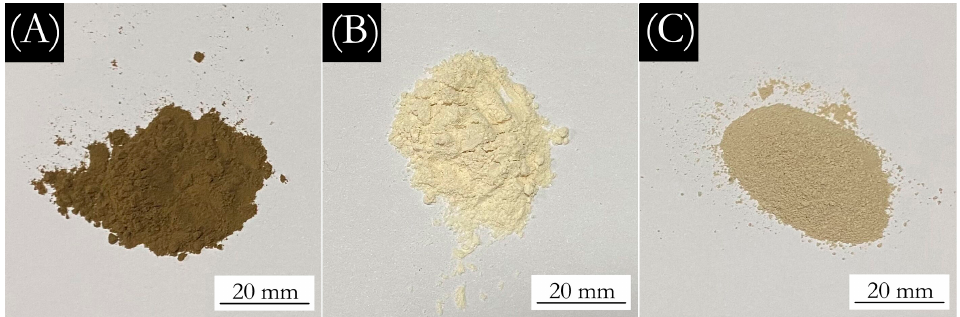
Figure 1. The macroscopic topography: ( A ) the aloin powder, ( B ) the aloin microcapsules prepared with ethanol as the solvent, and ( C ) the aloin microcapsules prepared with water as the solvent.